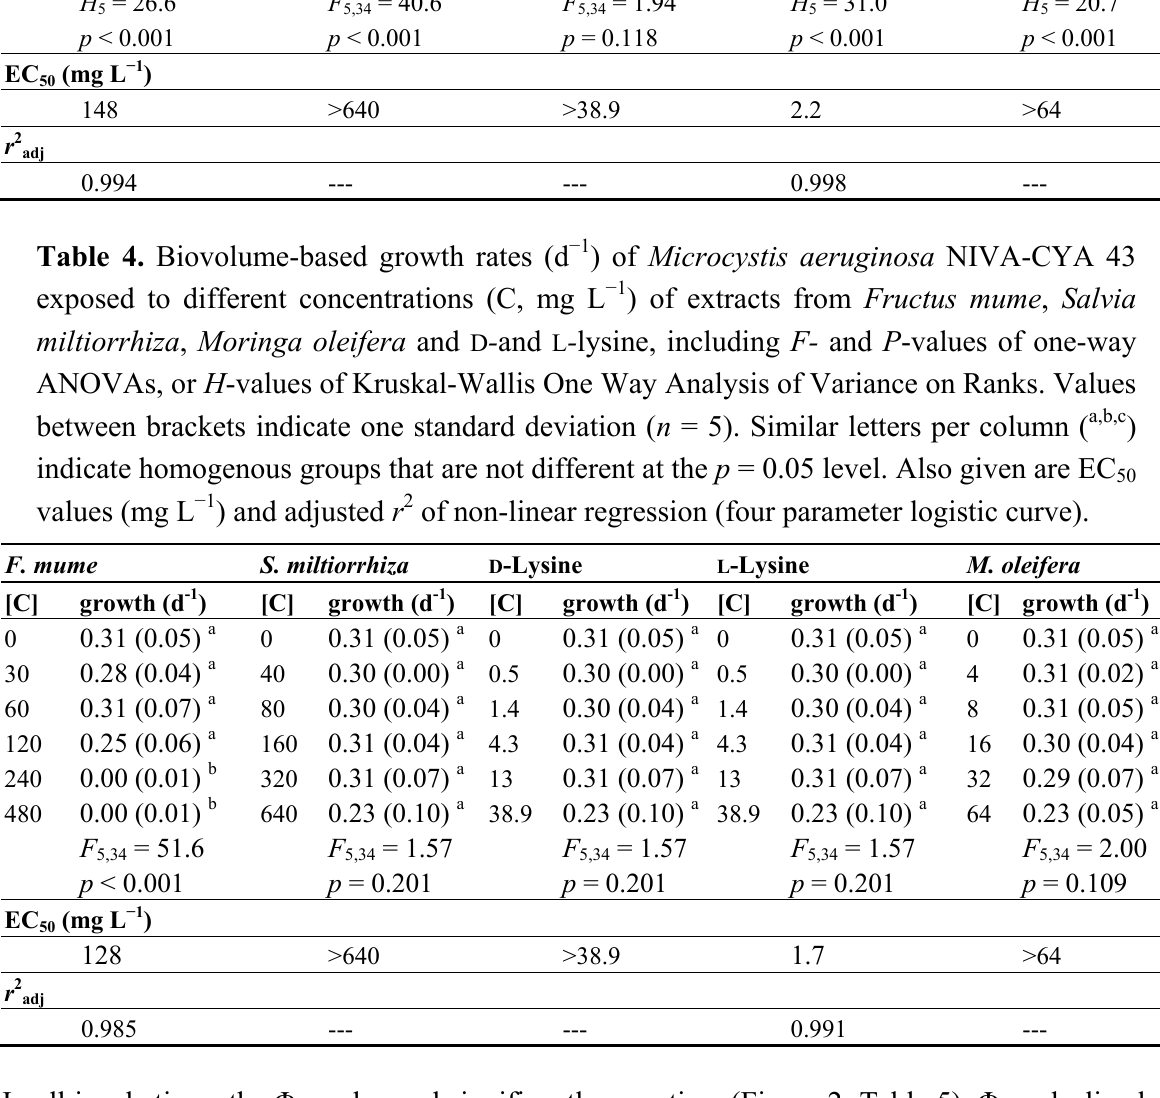
= 26.6 H 5 p < 0.001